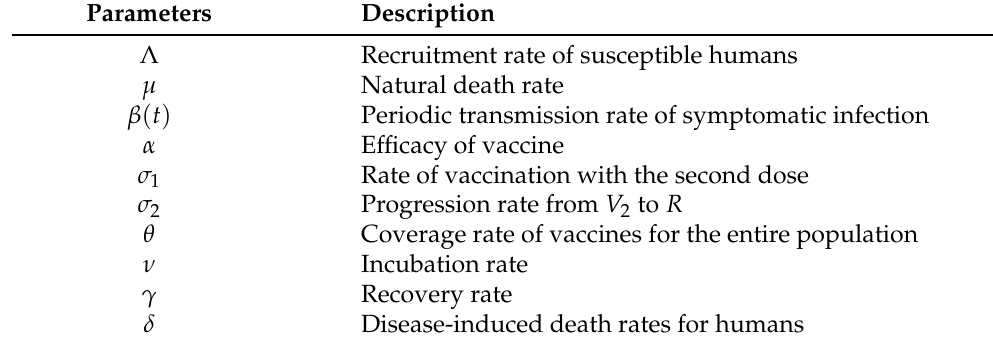
Figure 1. Schematic diagram of measles transmission in a population. Table 1. Description of parameters for model